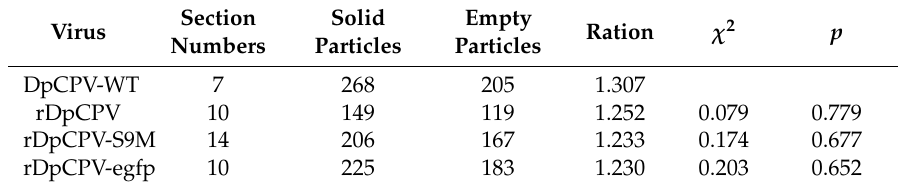
Table 3. Ratio of solid to empty virions in the OBs of wild-type and rescued